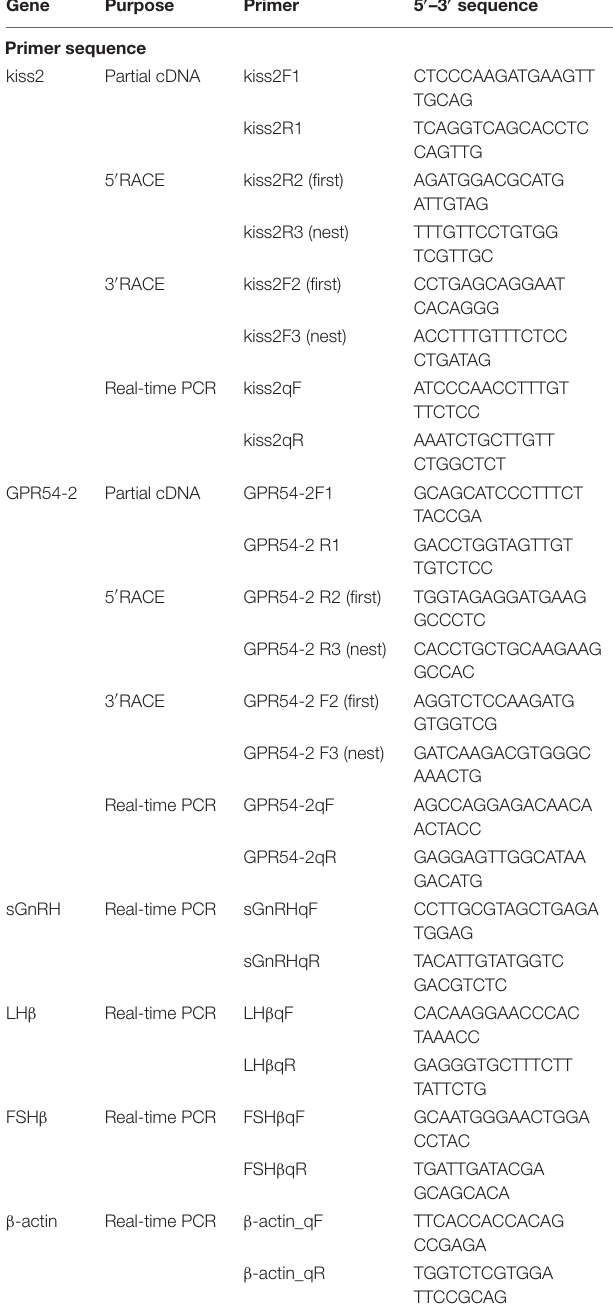
TABLE 1 | Information of primers used in this